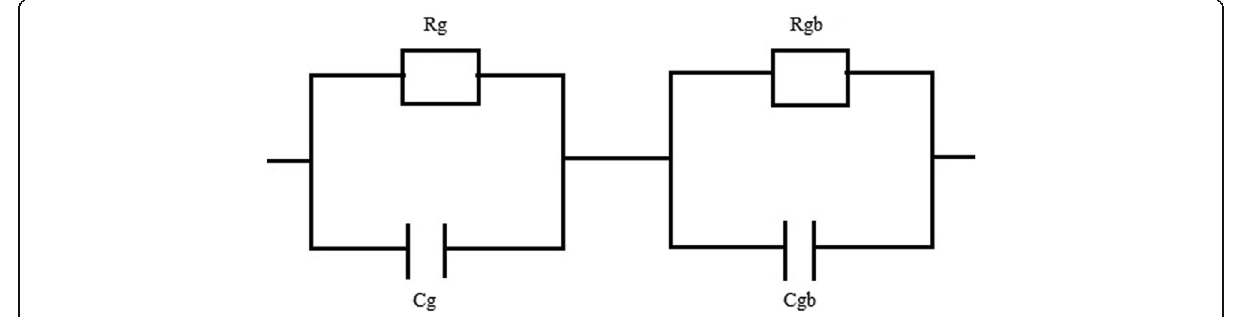
Fig. 8 Equivalent circuit for Nyquist ’ s plot ( Z ′ vs Z ″ ) for C1( x = 0.1, y = 0.45), C5( x = 0.5, y = 0.25), and C9( x = 0.9, y = 0.05)